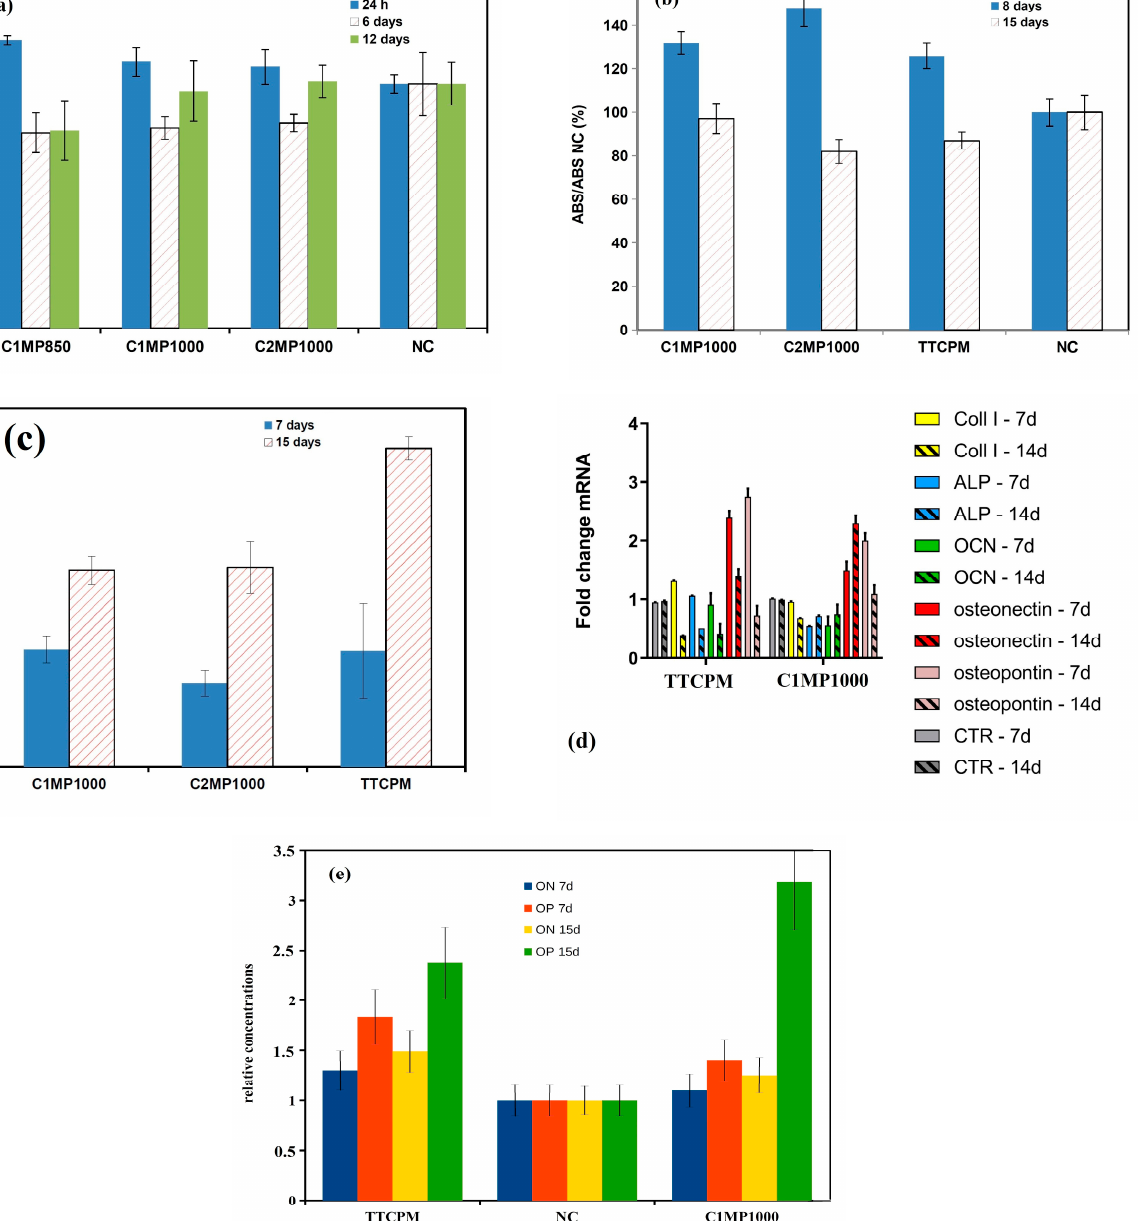
Figure 8. Viability of MSC’s cultured in C1MP850, C1MP1000, and C2MP1000 extracts for 24 h, 6 days, 12 days ( a ); cement extracts during the prolonged cultivation period of up to 15 days ( b ); ALP activity of MSC´s cultured in TTCPM, C1MP1000, and C2MP1000 extracts ( c ) relative gene expression of COL1, OC, ON, OP, and ALP in MSCs cultured for 7 and 14 days in TTCPM and C1MP1000 extracts ( d ) and relative concentration of On and OP determined by the Western blot (SDS PAGE) analysis of lysates from MSCs cultured in 50% TTCPM and C1MP1000 extracts ( e ).